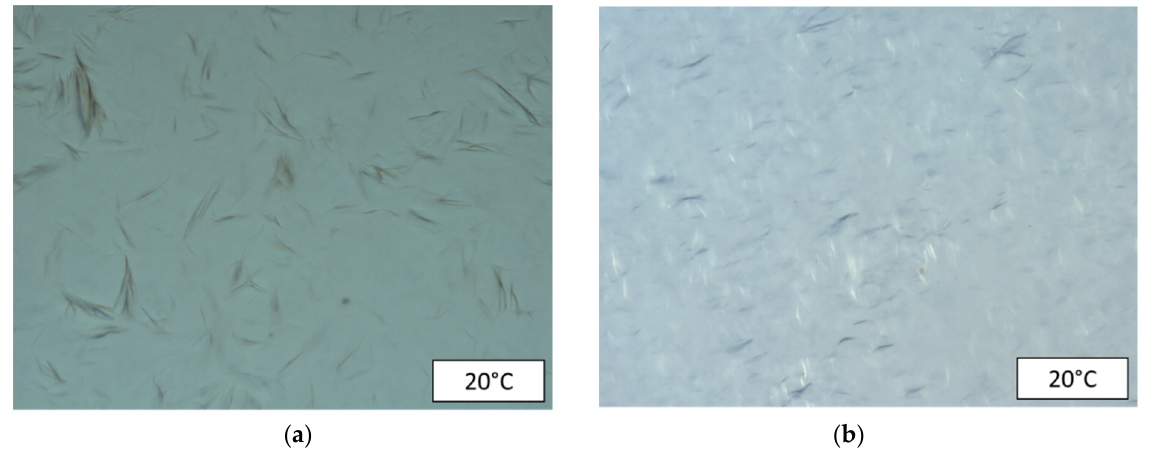
Figure 2. CPM images at 20 °C of oils ( a ) 2 and ( b ) 3. Wax crystals were not observed for oil 1 under the same conditions. the same